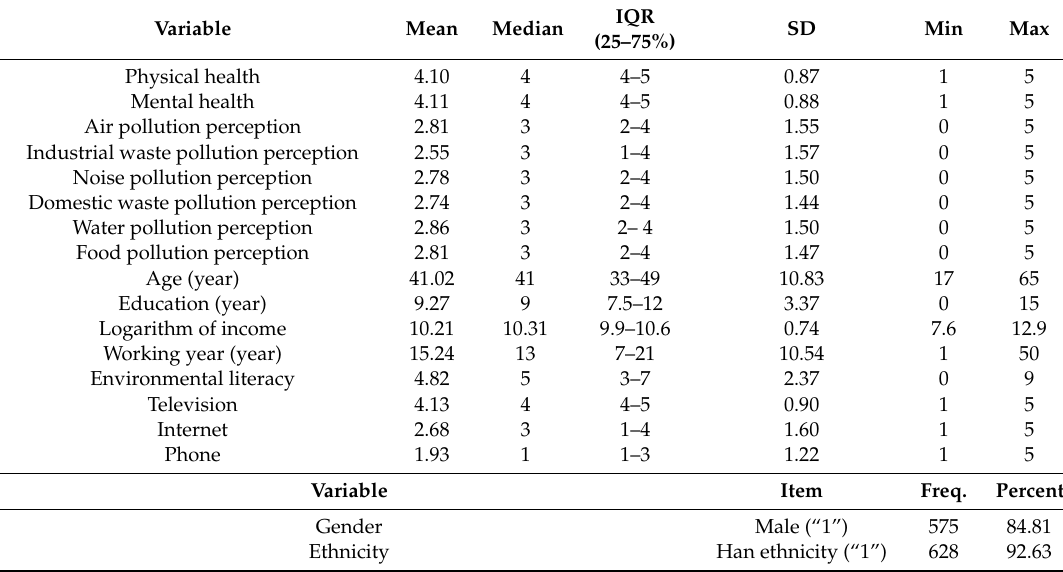
Table 1. Descriptive analysis ( N = 678).